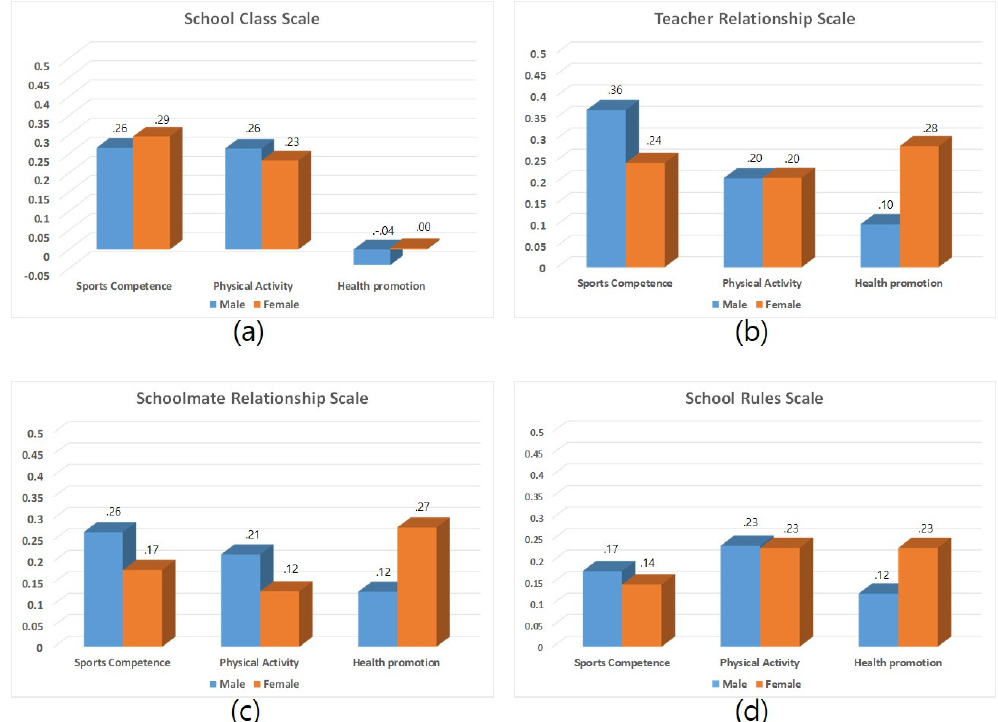
Figure 2. Effect of physical self-concept on school adjustment by gender: ( a ) school class differences, ( b ) teacher relationship differences, ( c ) schoolmate relationship differences, ( d ) school rules differences. Among students with an award-winning career, higher TRE corresponds to SCO ( β = 0.352, p < 0.001), while higher SCL corresponds to HP ( β = 0.262, p < 0.001), and higher SRE corresponds to PA ( β = 0.243, p < 0.001) respectively. Among those who did not win awards, higher TRE corresponds to SCO ( β = 0.267, p < 0.001), while higher TRE corresponds to HP ( β = 0.299, p < 0.001), and